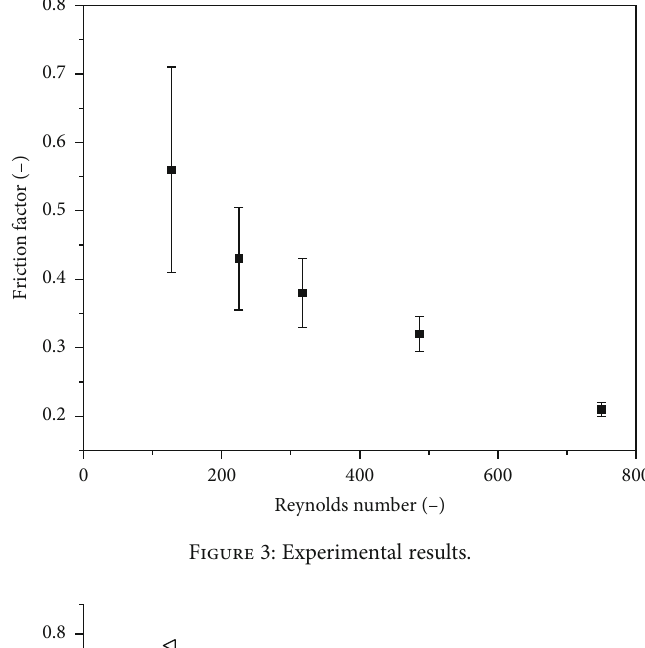
Figure 3: Experimental results.